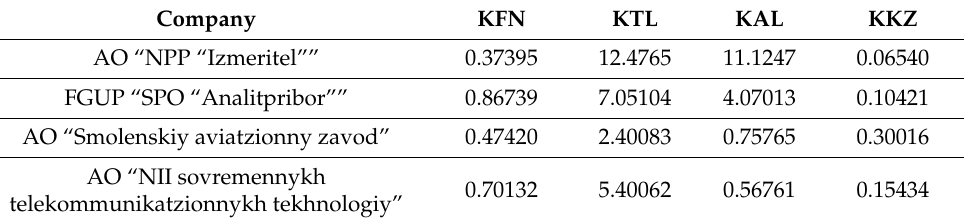
Table 3. Indicators of the efficiency and sustainability of companies in the Smolensk region as of 2019. Company